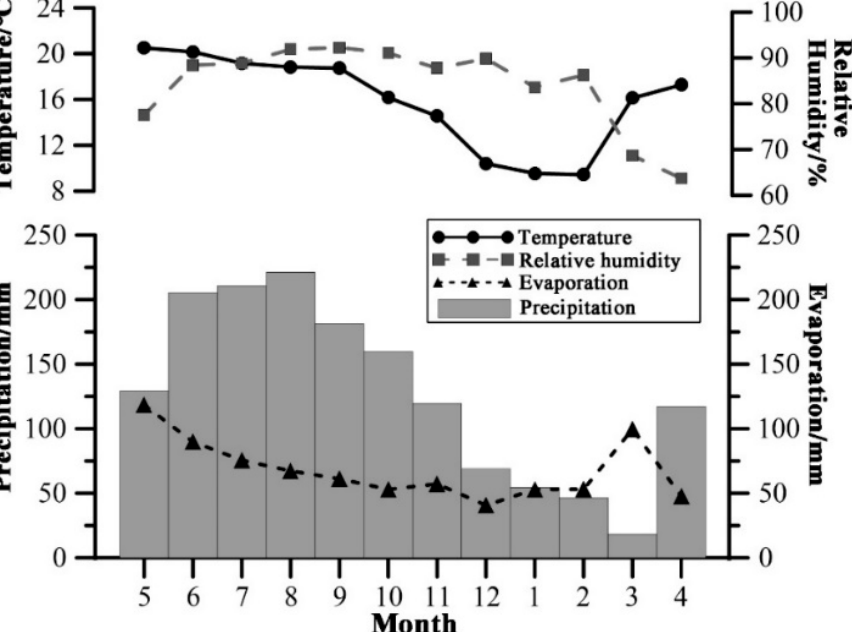
Figure 2. Monthly average temperature, relative humidity, evaporation, and precipitation data were collected from April 2015 to July 2016 at the weather stations (Y3).